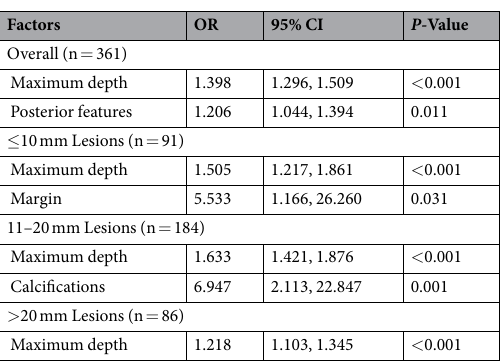
Table 3. Binary Logistic Regression Analysis in the Prediction of Low Quality Measurement for Breast Lesions. OR = Odds ratio; Posterior features = enhancement, shadowing and combined